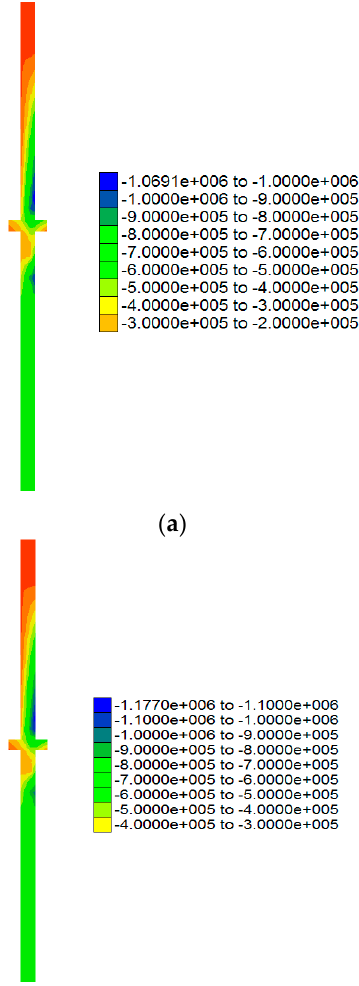
Figure 20. Comparison of maximum principal stress distribution of cut-off wall at monitoring surface. ( a ) 1. ( b ) 2.